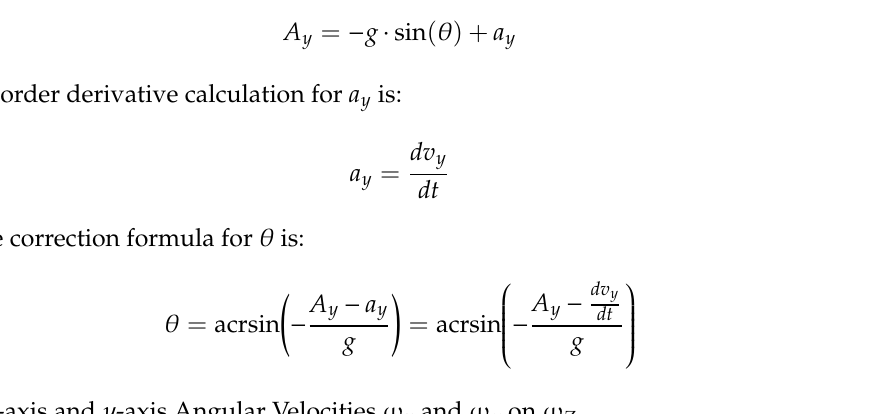
E ff ect of the x -axis and y -axis Angular Velocities ω x and ω y on ω